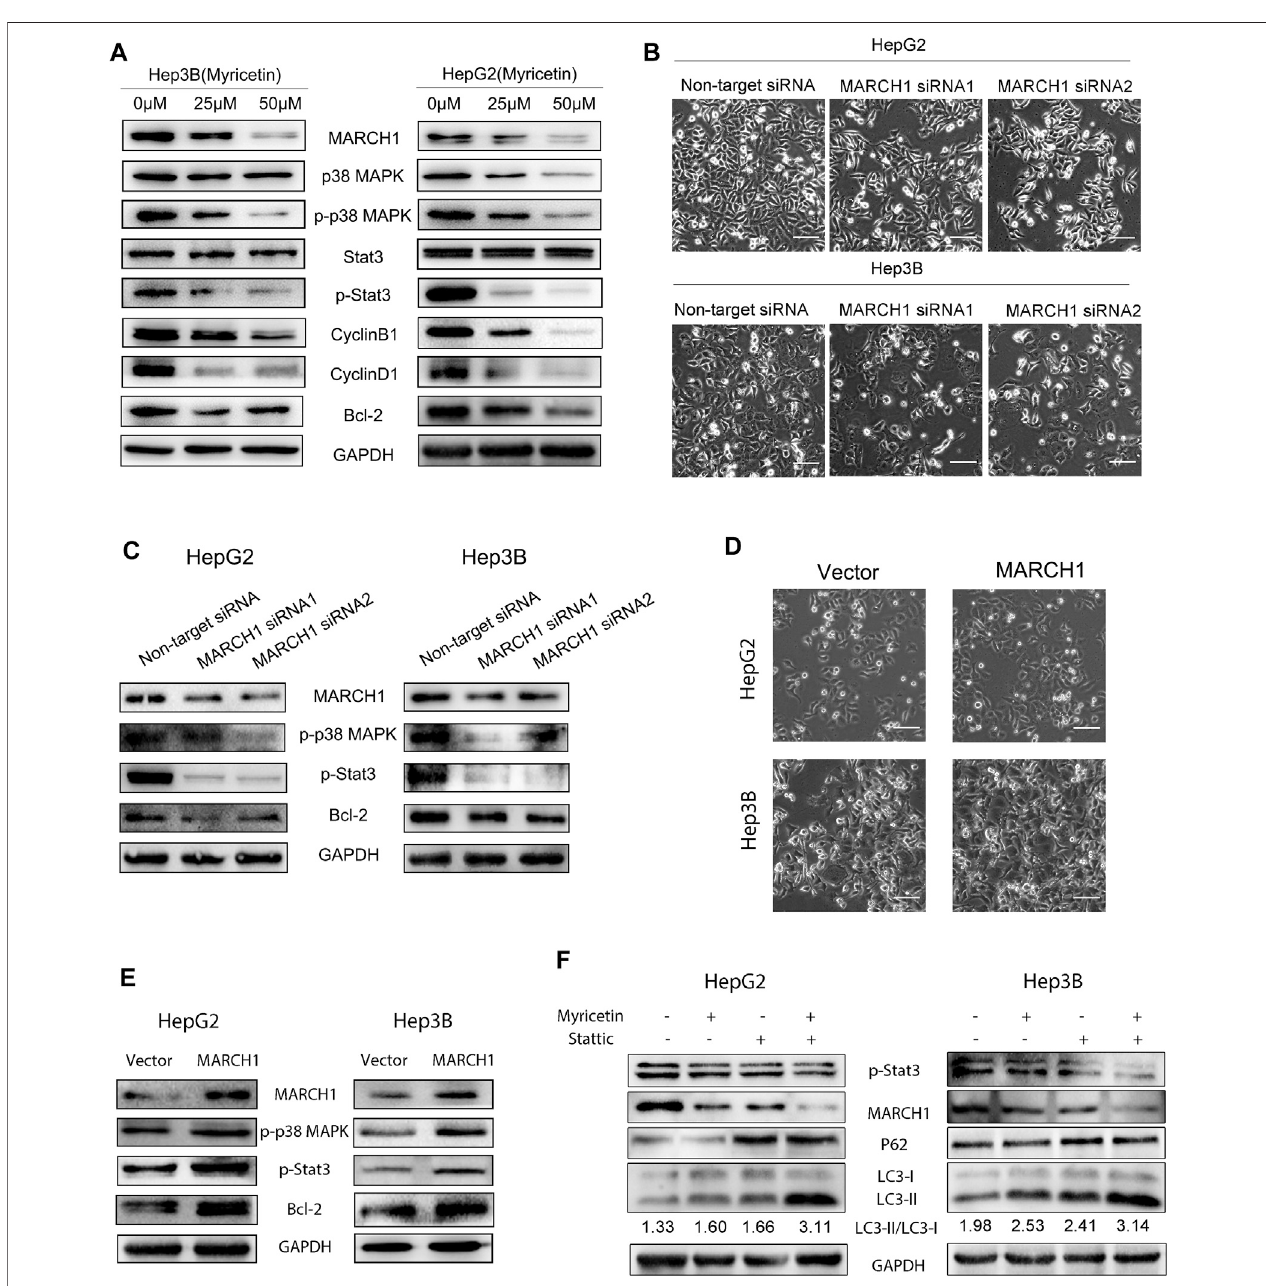
FIGURE 5 | Myricetin induces autophagy and cell cycle arrest of HCC cells via downregulating MARCH1-mediated p38 MAPK/Stat3 signaling pathway. (A) HCC cells were treated with 0, 25, 50 μ M myricetin for 24 h p38 MAPK and Stat3 signaling pathway proteins and cell cycle proteins were analyzed by Western blot. (B) Above images show the viability of HCC cells transfected with or without siRNA MARCH1 for 48 h (bar: 100 μ m). (C) The p-p38 MAPK, p-Stat3, and Bcl-2 were detected byWestern blot analysisafter transfected siRNA MARCH1 or nontarget siRNA in HCC cells. (D) Thegrowth abilityofHep3B and HepG2 cells transfectedwithorwithoutMARCH1-plasmidsisshowninthe fi gure(bar:100 μ m). (E) HCCcellsweretransfectedwithMARCH1plasmidsfor48 handconductedwith Western blot to measure the expression of p -pretreatp38 MAPK, p-Stat3 and Bcl-2 proteins. (F) HCC cells were treated with a combination of 50 μ M myricetin and 2.5 μ M Stattic (for 4 h) for 24 h. Western blot was used to analyze the expression of MARCH1, LC3, P62.